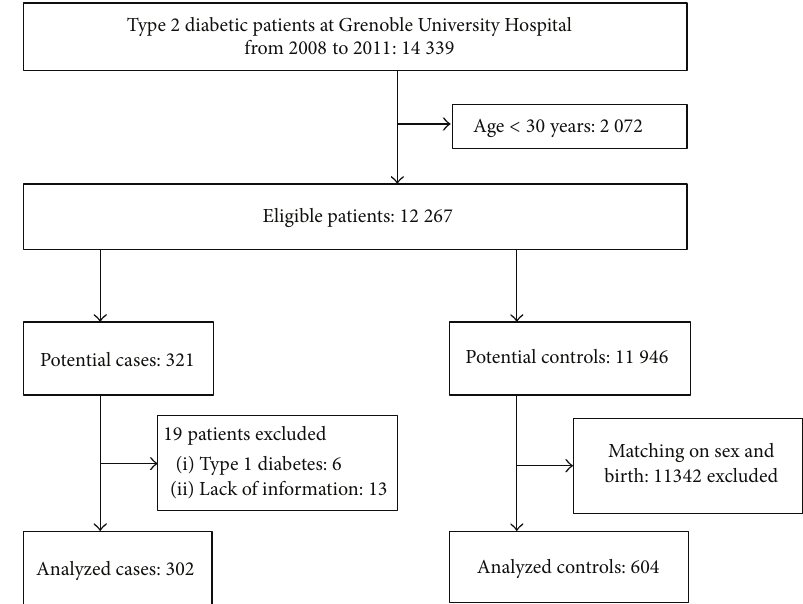
Figure 1: Study flow